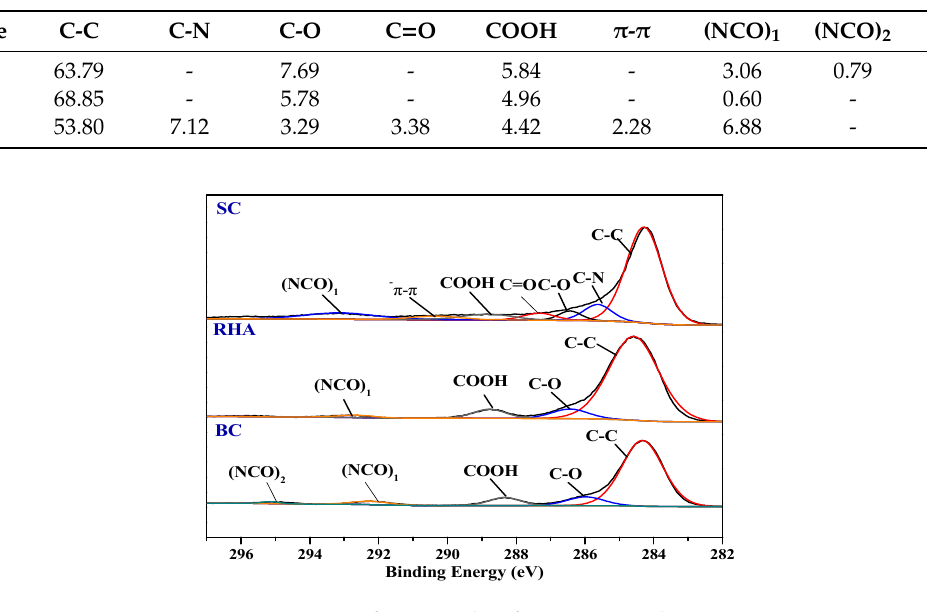
Figure 6. XPS fitting peaks of BC, RHA, and SC. Table 4. C1s fitting peaks of three biochars.